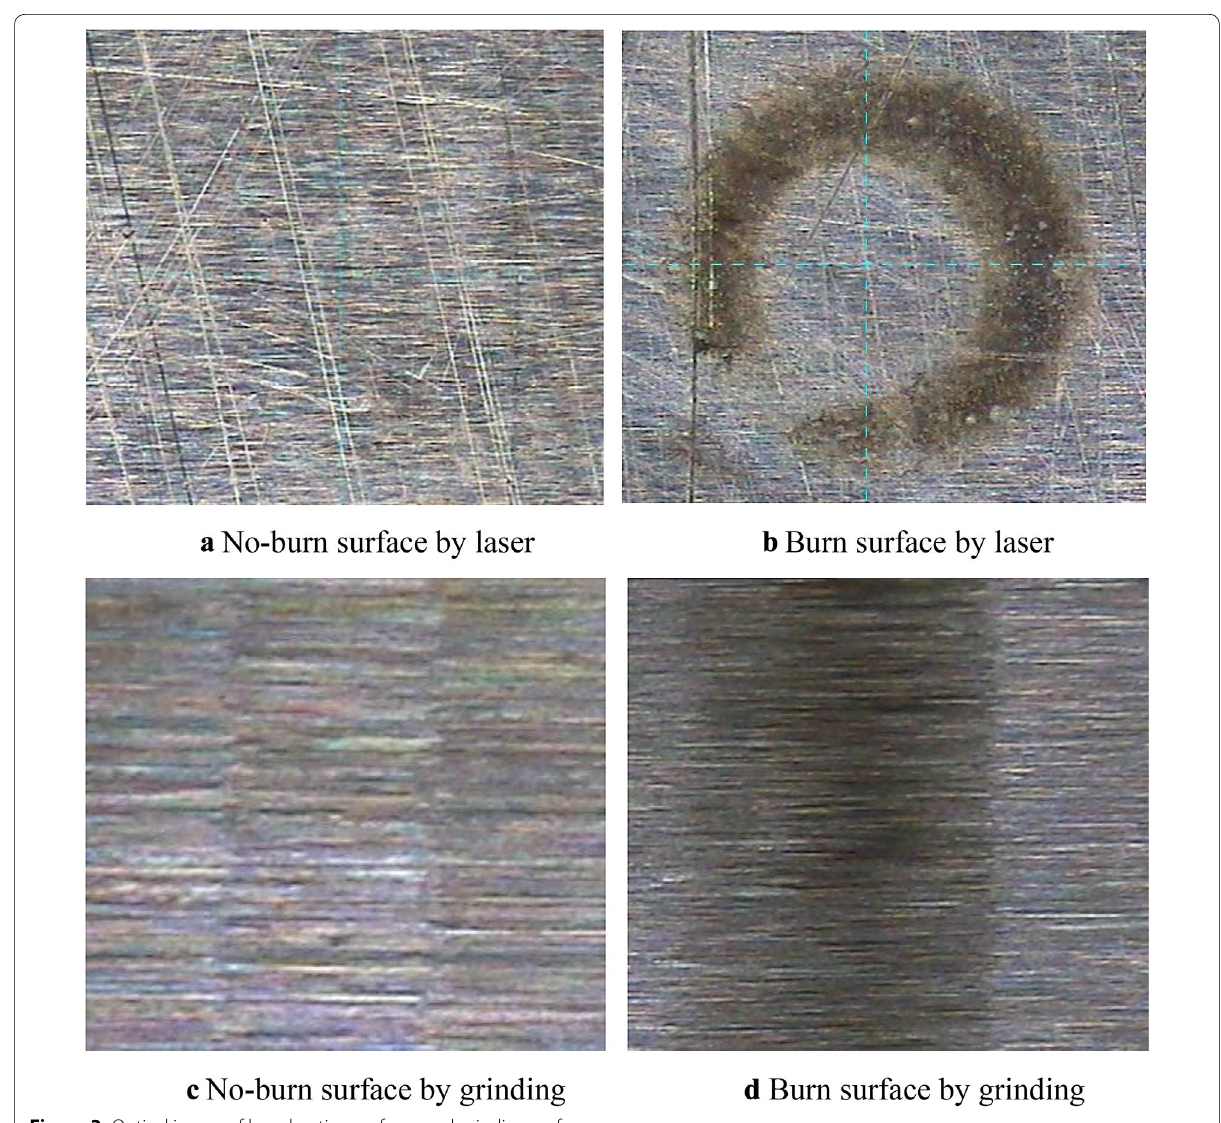
Figure 3 Optical image of laser heating surfaces and grinding